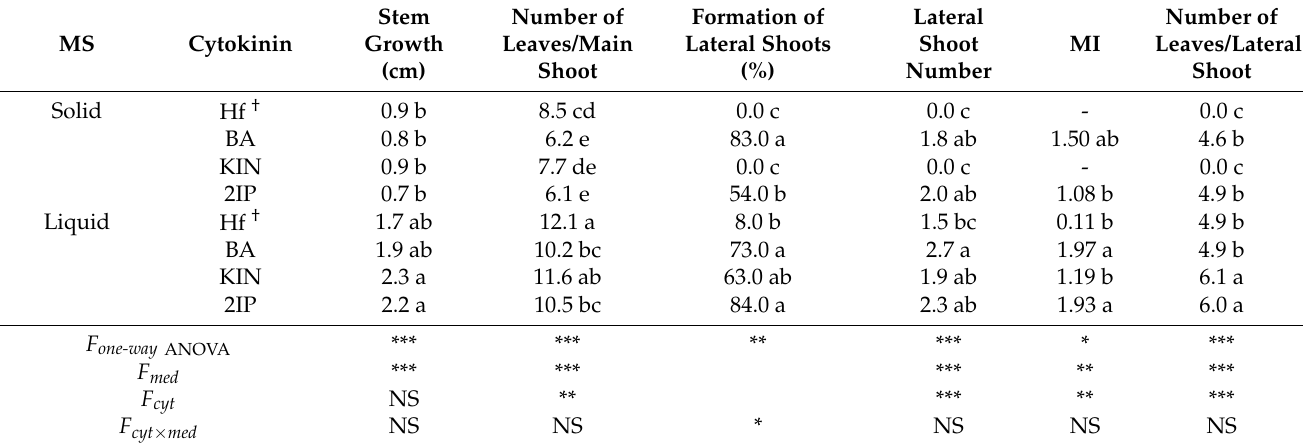
Table 3. Effect of cytokinin type and concentration on shoot proliferation from shoot explants, excised from plantlets on solid and liquid media containing BA, KIN, or 2IP, at 1.0 mg L − 1 , or